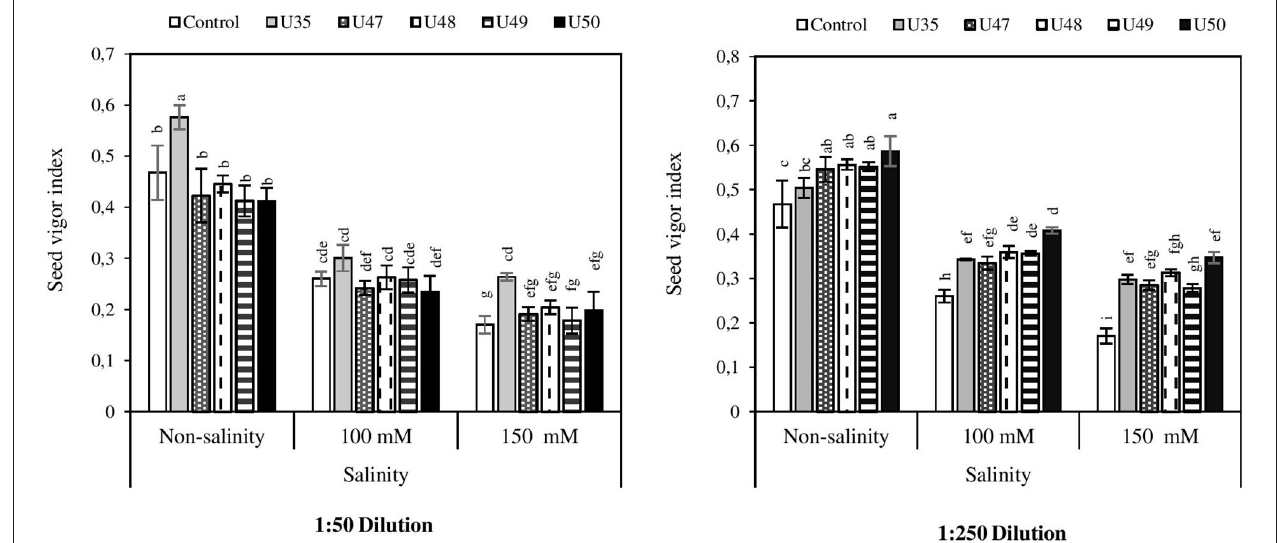
FIGURE 4 | Effect of 1:50 and 1:250 dilutions of Bacillus strain CFSs (U35, 47, 48, 49, and 50) and salinity on corn seed vigor index. Values mean of five replicates ± SD. 1:50 = 1mL Bacillus strain CFSs and 50mL distilled water and 1:250 = 1mL Bacillus strain CFSs and 250mL distilled water.